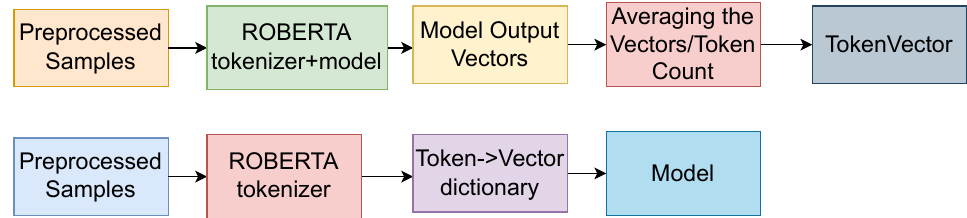
Figure 9. Transformer token vector